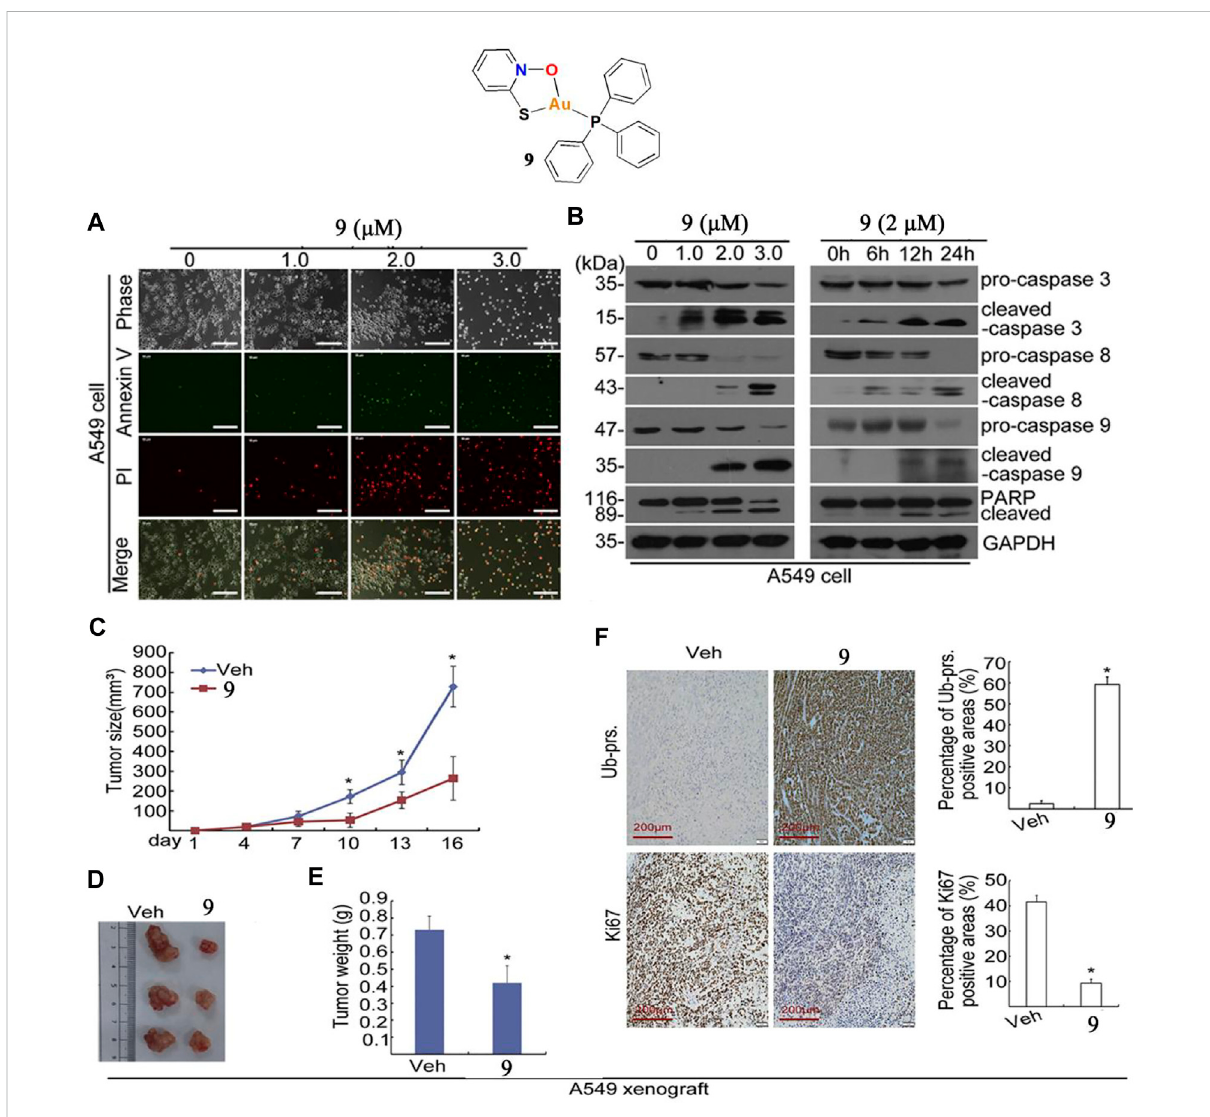
FIGURE 6 (A) Apoptotic cells were detected by Annexin V-FITC/PI staining after treatment with complex 9 . (B) Western blot analysis of caspase-3, 8, and nine in A549 cells after treatment with complex 9 . (C – F) BALB/c nude mice bearing A549 tumors after treatment with complex 9 (7 mg/kg/day) for 16 days. Reproduced with permission (Liu et al.,